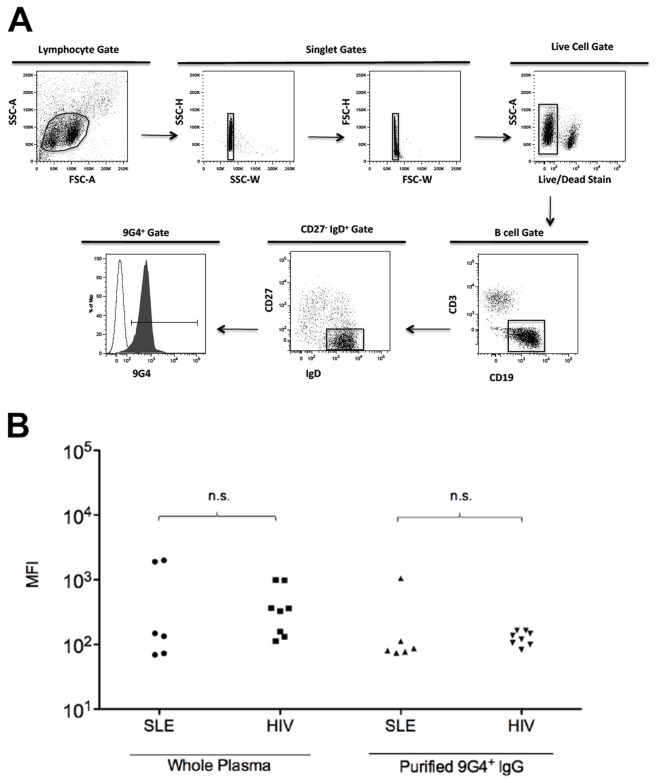
9G4+ antibodies from SLE and HIV-infected patients bind B cells.Tonsil cells were incubated with either patient plasma, purified 9G4+ antibodies from patients’ plasma or a positive control 9G4+ monoclonal antibody then stained with fluorescently -labeled antibody cocktails. (A) Gating strategy: lymphocytes were gated based on size and granularity followed by an exclusion of doublets. Dead cells were excluded using a viability stain then live cells were then gated by expression of CD3 and CD19. CD3-CD19+ B cells were then further divided by IgD and CD27 markers. The open histogram represents the no antibody source control (PBS alone). The solid histogram is representative of 9G4+ antibody binding B cells. (B) B cell binding of 9G4+ antibodies purified from SLE (n=6) and HIV- infected (n=8) patients was assessed. Significance was determined by Mann-Whitney test.